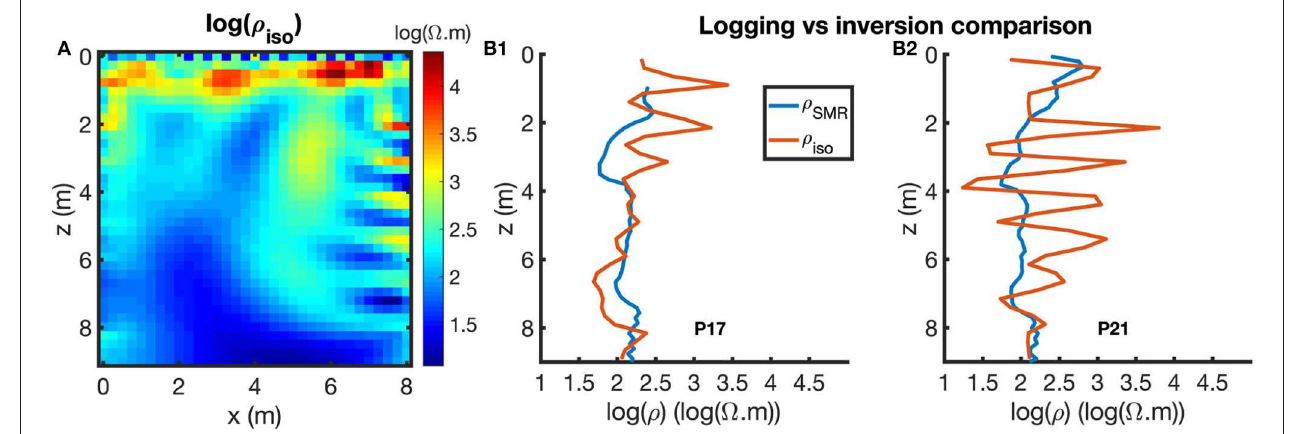
FIGURE 7 | Real case study isotropic inversion results displaying logarithmic inverted resistivities. (A) Inverted results from the apparent resistivities acquired between P17 (x 0 m) and P21 (x 8 m) on the tomography site ( Figure 1 ). (B) Comparison between the logged ( ρ SMR , blue curves) and the inverted isotropic ( ρ H , red = = curves) resistivities (corresponding to the P17 [B1] and P21 [B2]